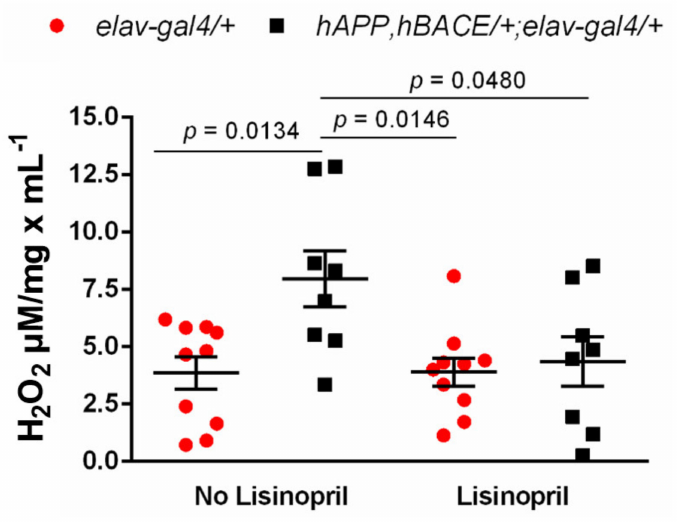
Figure 3. Lisinopril reduces the abundance of reactive oxygen species in muscle-enriched thoraces of AD males. Untreated hAPP , hBACE/+ ; elav-gal4/+ AD flies displayed higher thoracic H 2 O 2 levels than untreated and lisinopril-fed elav-gal4/+ controls. Lisinopril treatment significantly decreased the levels of H 2 O 2 in AD flies compared to the untreated AD flies. Error bars represent the S.E.M. p-values obtained from Tukey–Kramer post hoc tests for multiple